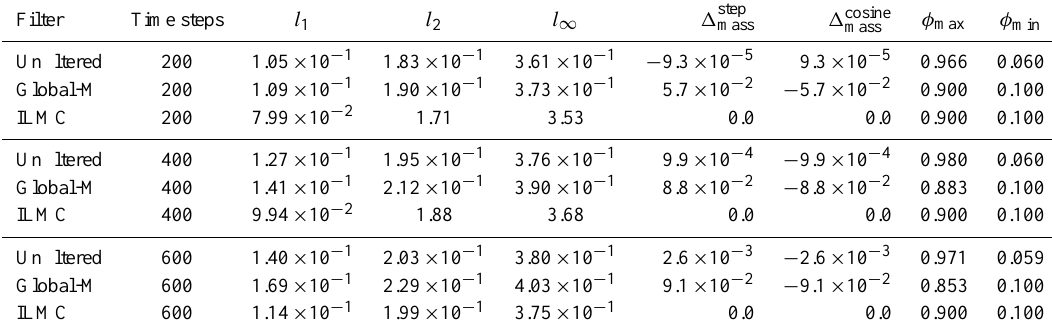
Table 1. Error norms for global filter test: the table shows the three solutions’ error norms as well as mass change for the step and cosine hill functions, and the maximum and minimum values. The velocity is 0.5 and the domain is 100 units long, so the time steps correspond to one, two, and three